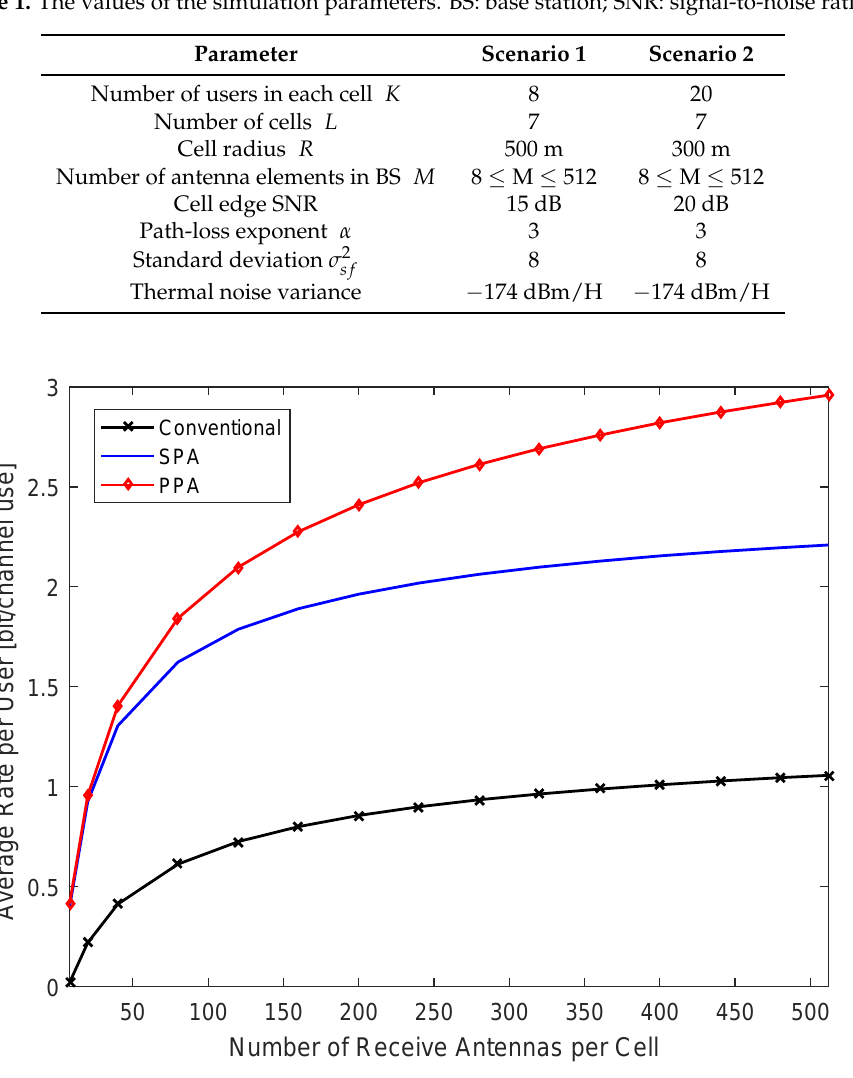
Figure 3. Average uplink rate per user for various numbers of antenna elements using a zero forcing (ZF)